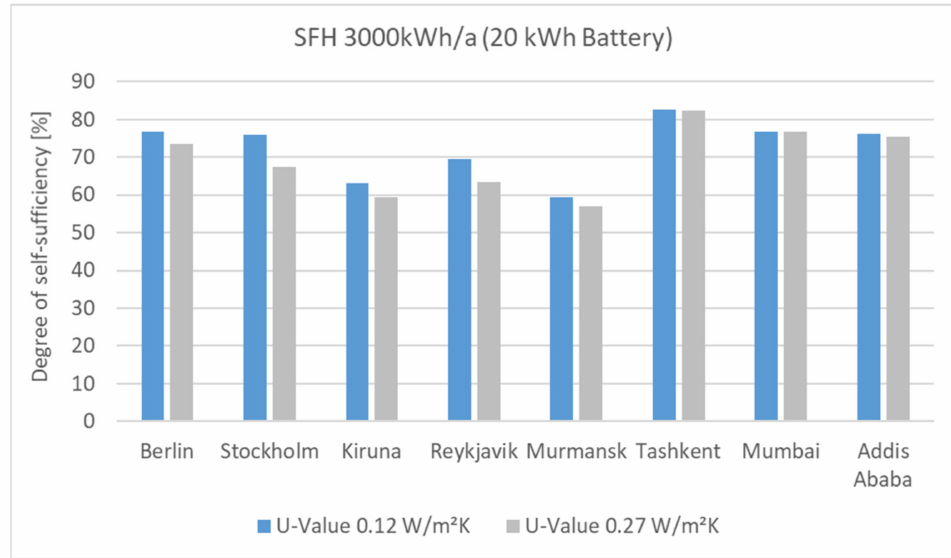
Figure 20. Degree of self-sufficiency for several locations with a changed heat transfer coefficient (U) of the building with a 20-kWh battery (single-family